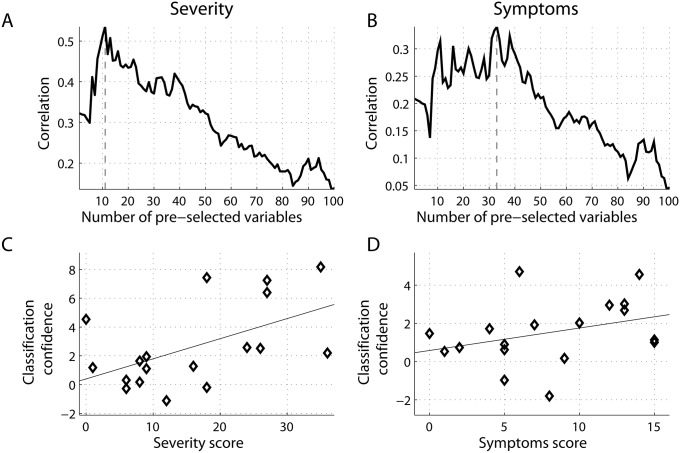
Correlations between the classification confidence (MEG-based measures) and self-reported clinical scores.(A) severity; and (B) symptoms for mTBI patients. The higher confidence that a given subject is classified as having mTBI, the higher the corresponding clinical scores. The correlations are shown as functions of the number of best features extracted from alpha connectivity and ranked before training. Scatter plots between classification confidence and clinical scores are shown at specific thresholds: k = 11 and k = 33 for (C) severity score; and (D) symptoms scores, respectively.